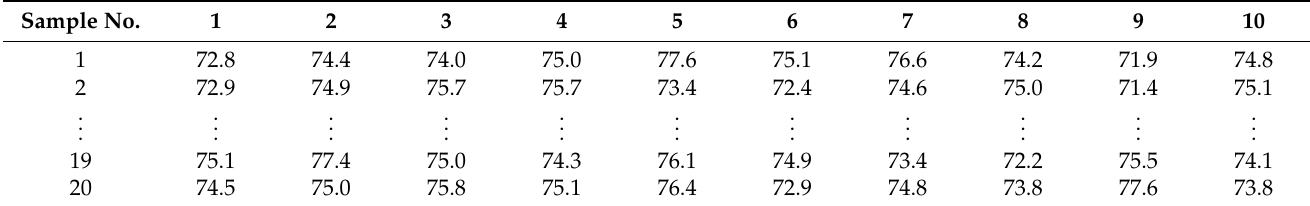
Table 15. Samples for temperature response after applying the optimization method.